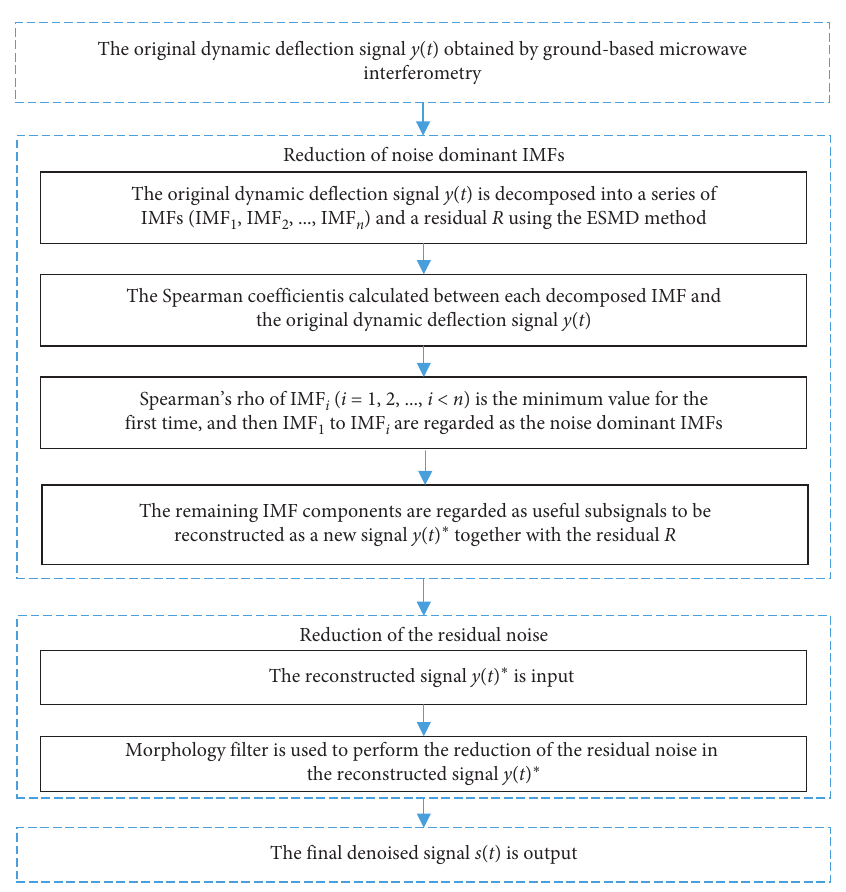
Figure 1: Workflow of the MF-ESMD denoising